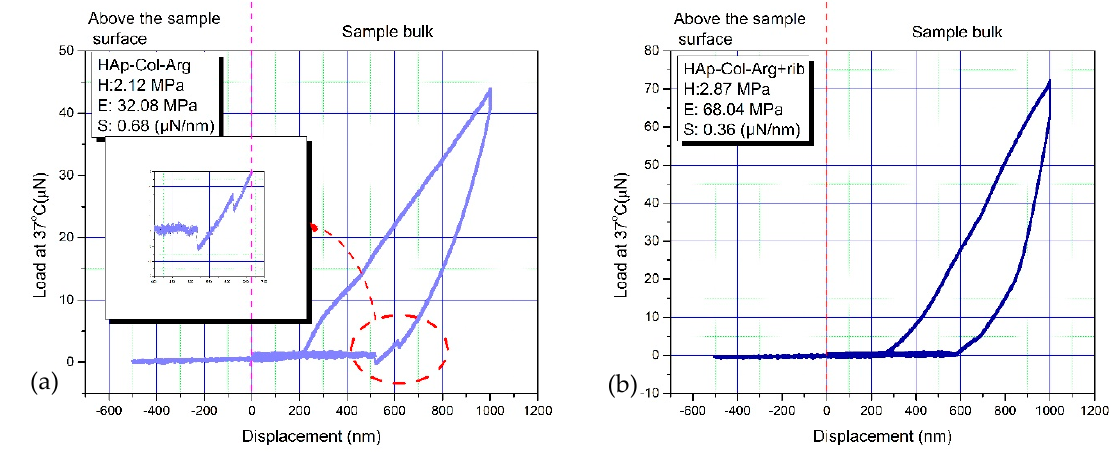
Figure 9. A load-displacement curve for a 3D hybrid scaffold: ( a ) without crosslinking and ( b ) crosslinked with 0.01% riboflavin.